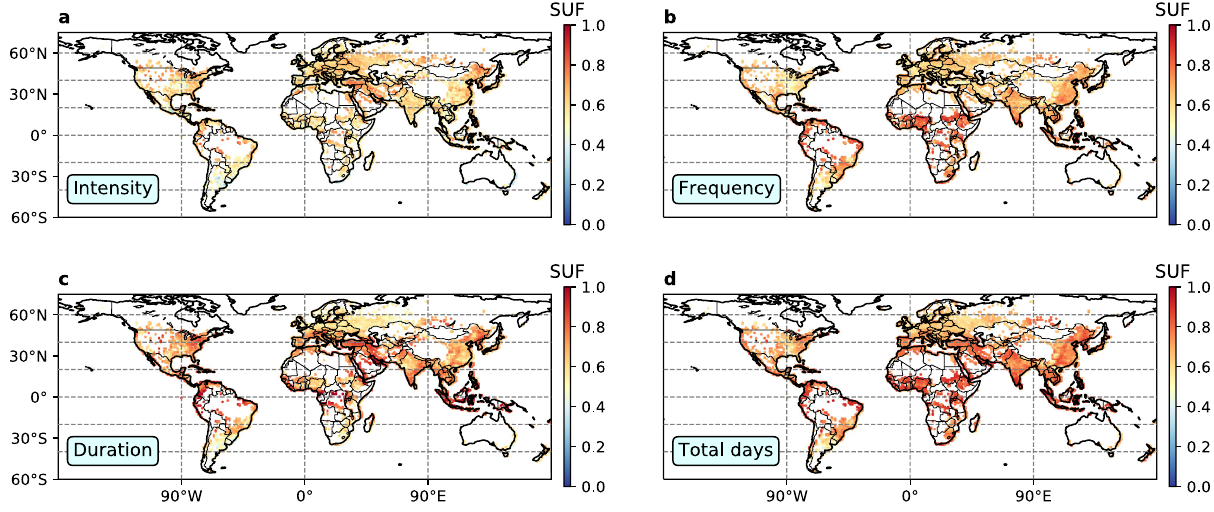
Fig. 3 Relative contribution of the model structural variability in urban heat wave projections in 2061 – 2070 relative to 2006 – 2015 under RCP 8.5. a intensity; b frequency; c duration; and d total days. Each colored point represents a decadal mean structural uncertainty fraction (SUF) de fi ned as σ CMIP σ deviation across multi-member